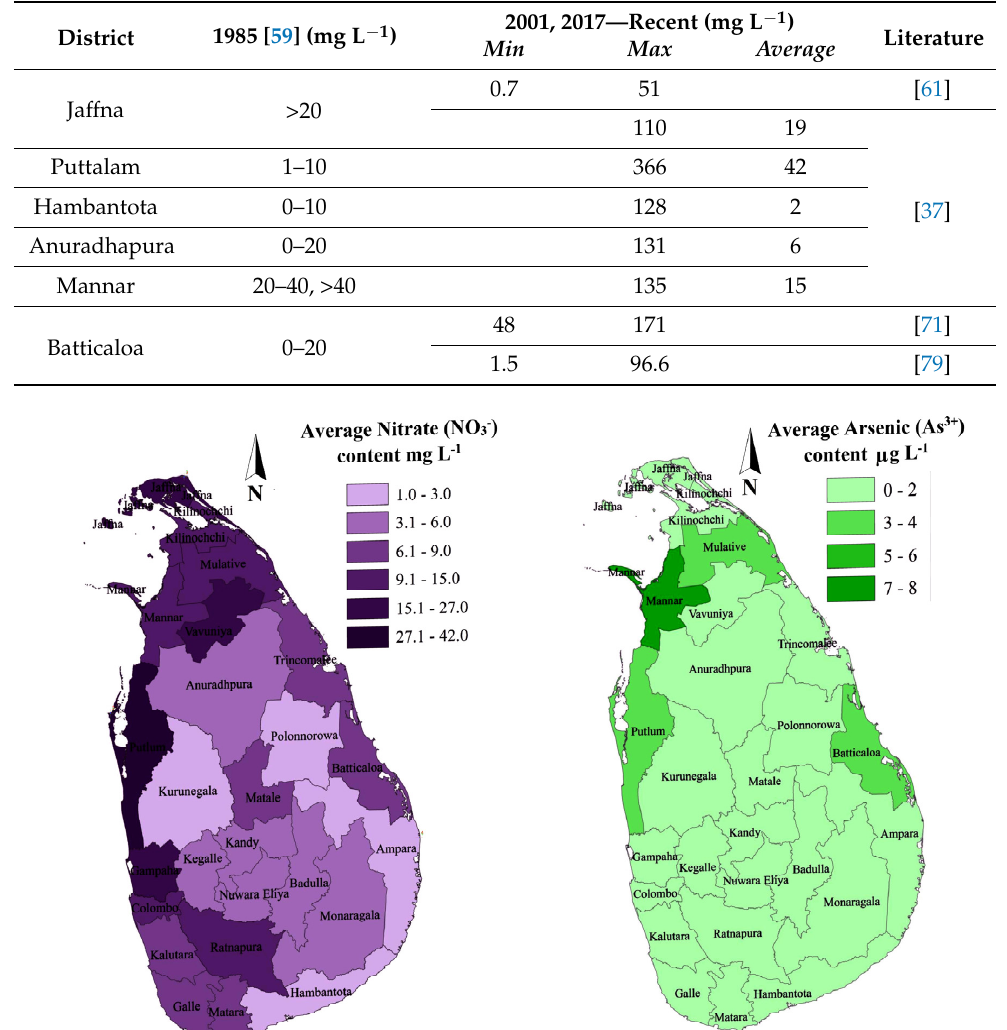
Table 4. Temporal variation of nitrate in groundwater of different agricultural regions in Sri Lanka, from 1985 to present.